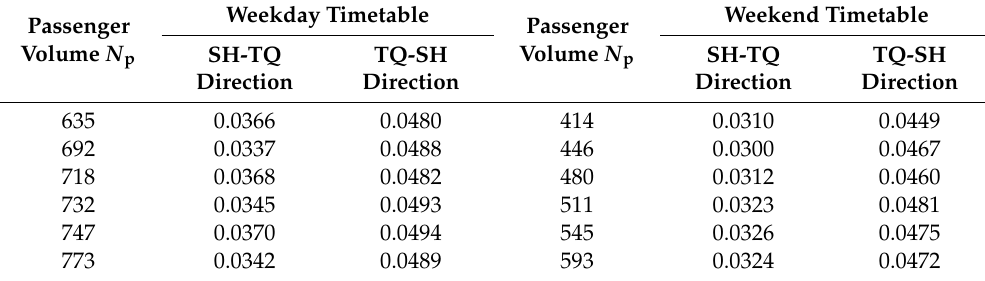
Table 5. Comparison of fitting slopes of ASS-REN-PLF upper boundaries.